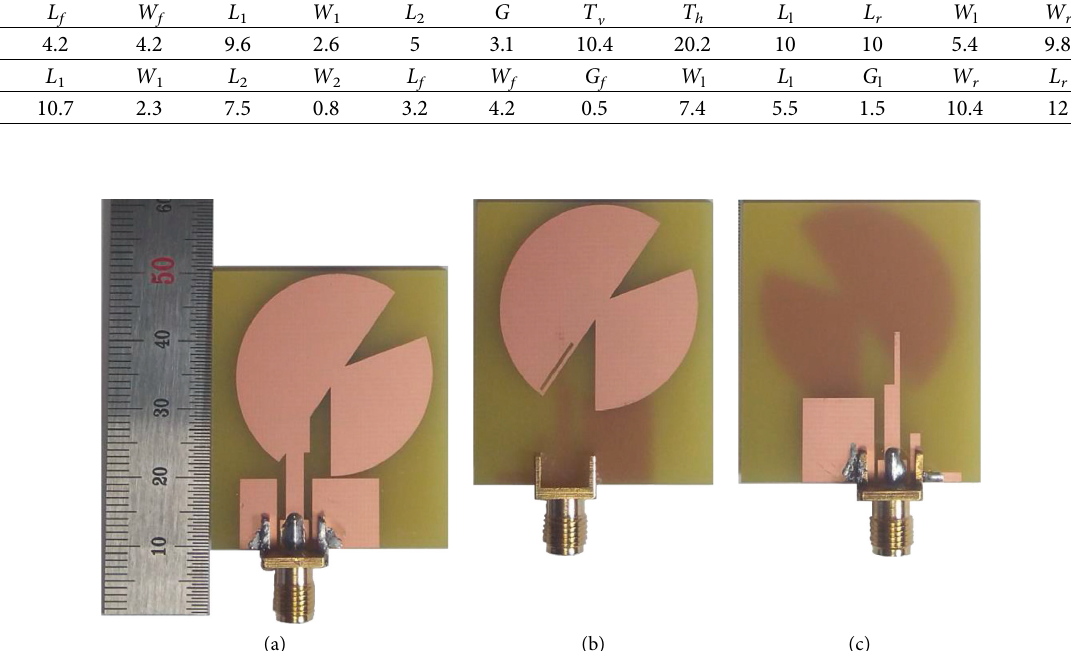
Figure 12: (a) Fabricated An1. (b) The top view of fabricated An2. (c) The back view of fabricated An2.